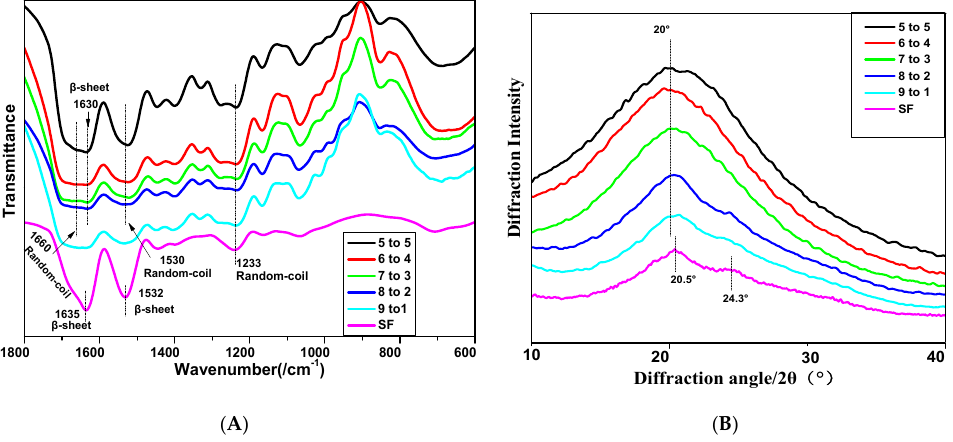
Figure 2 . Structure of fibroin hydrogels. ( A ) FTIR; ( B ) X-ray diffraction. The solid content of hydrogel was 10 g/L.